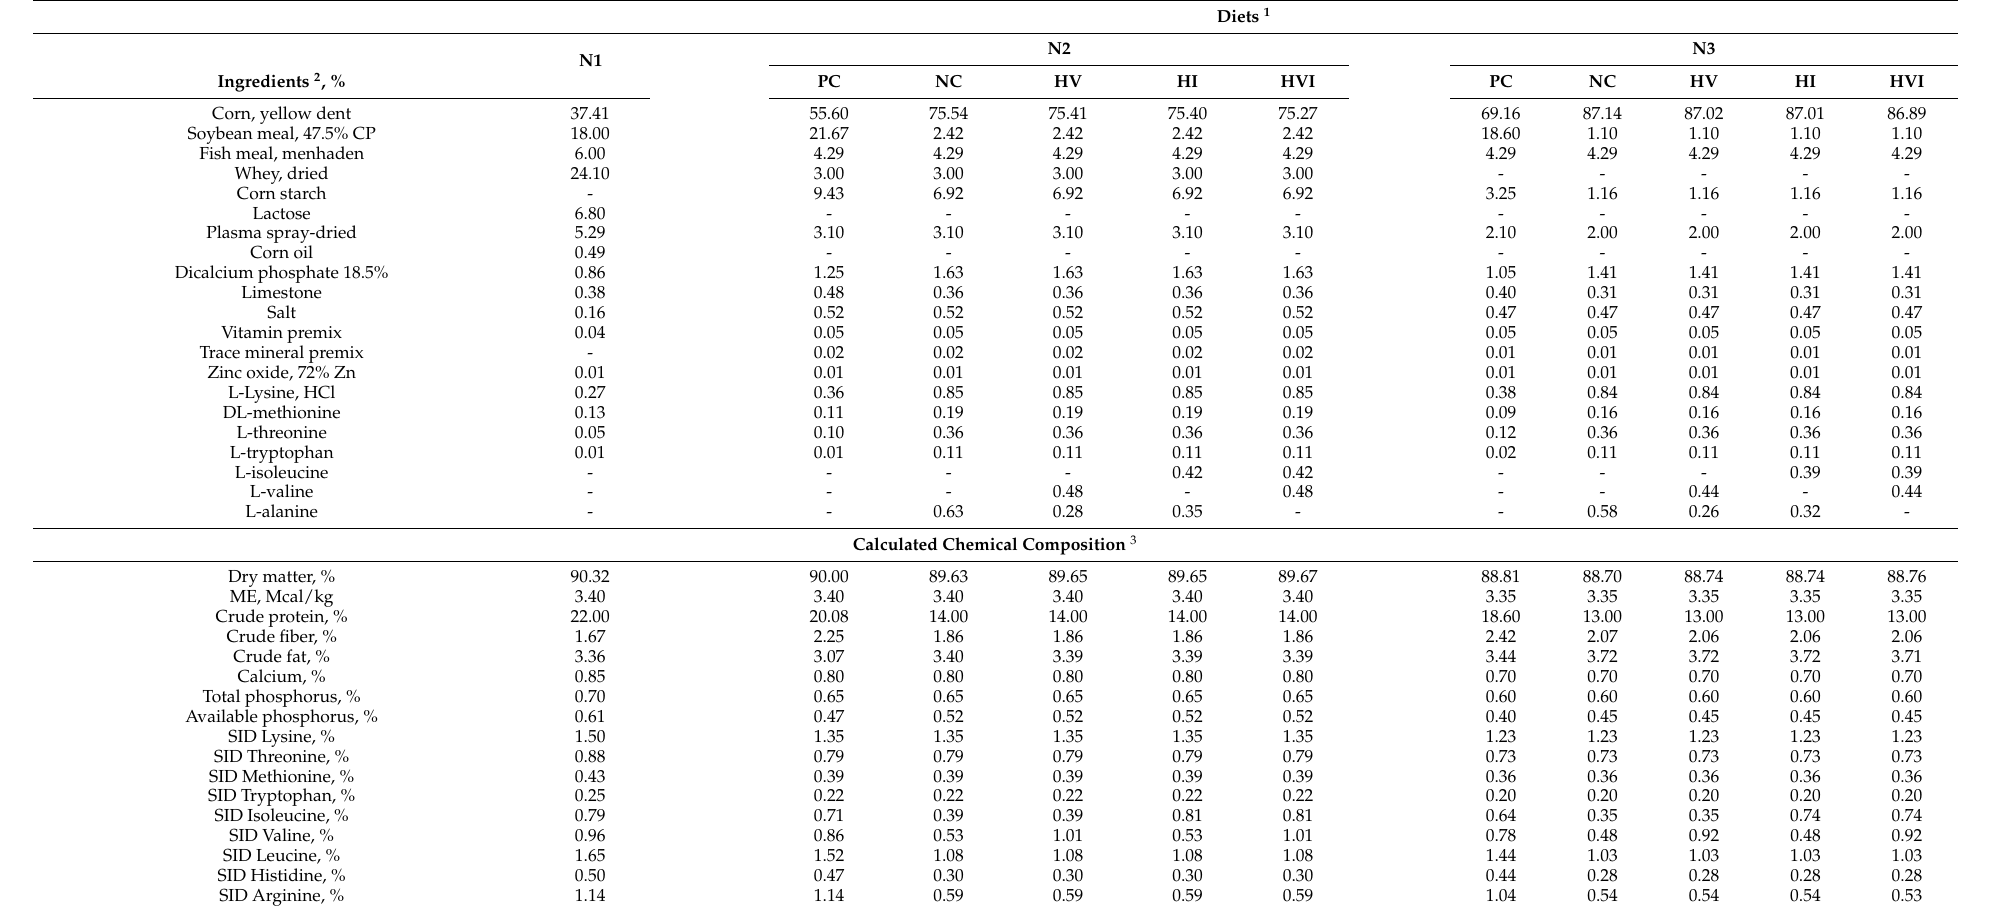
Table 1. Ingredients and chemical composition of experimental diets (as-fed